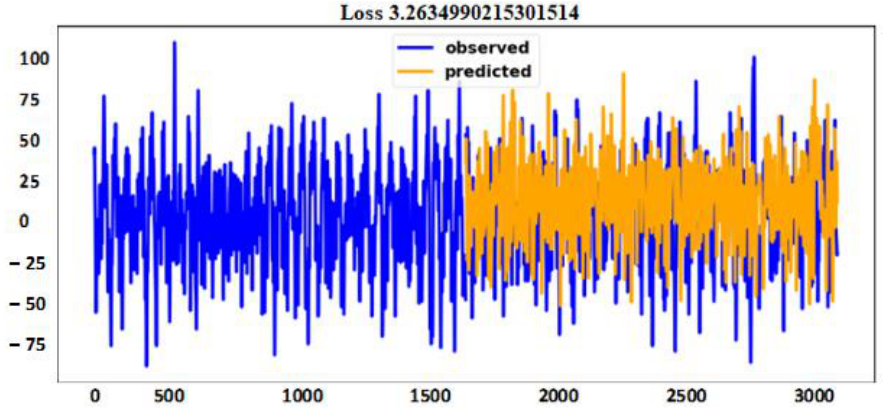
Figure 4. Application of the N-BEATS forecasting method.